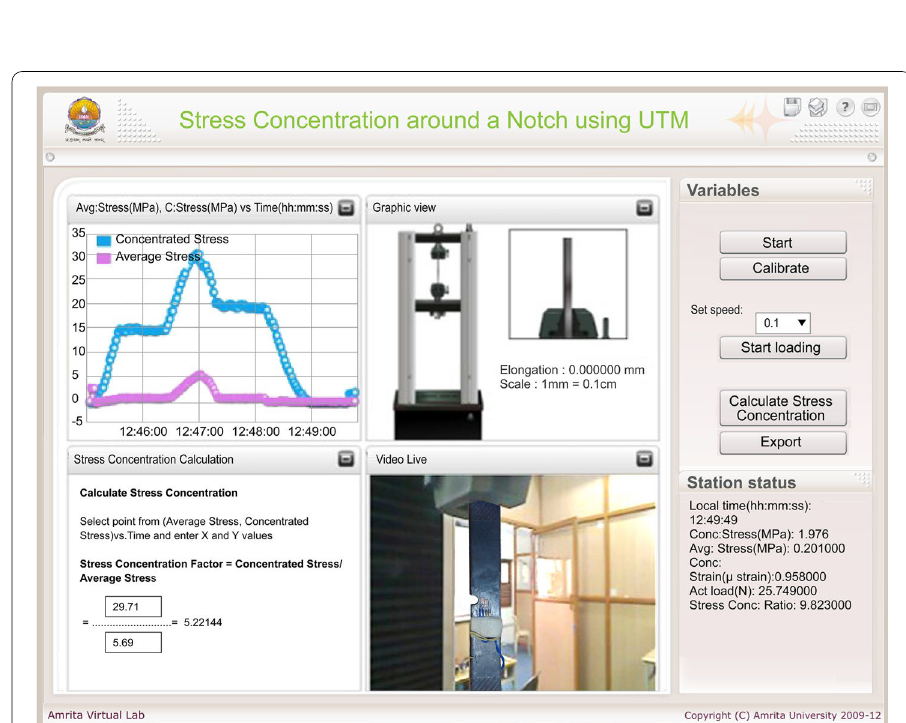
Fig. 9 Client-side UI to study stress concentrations on a plate with a